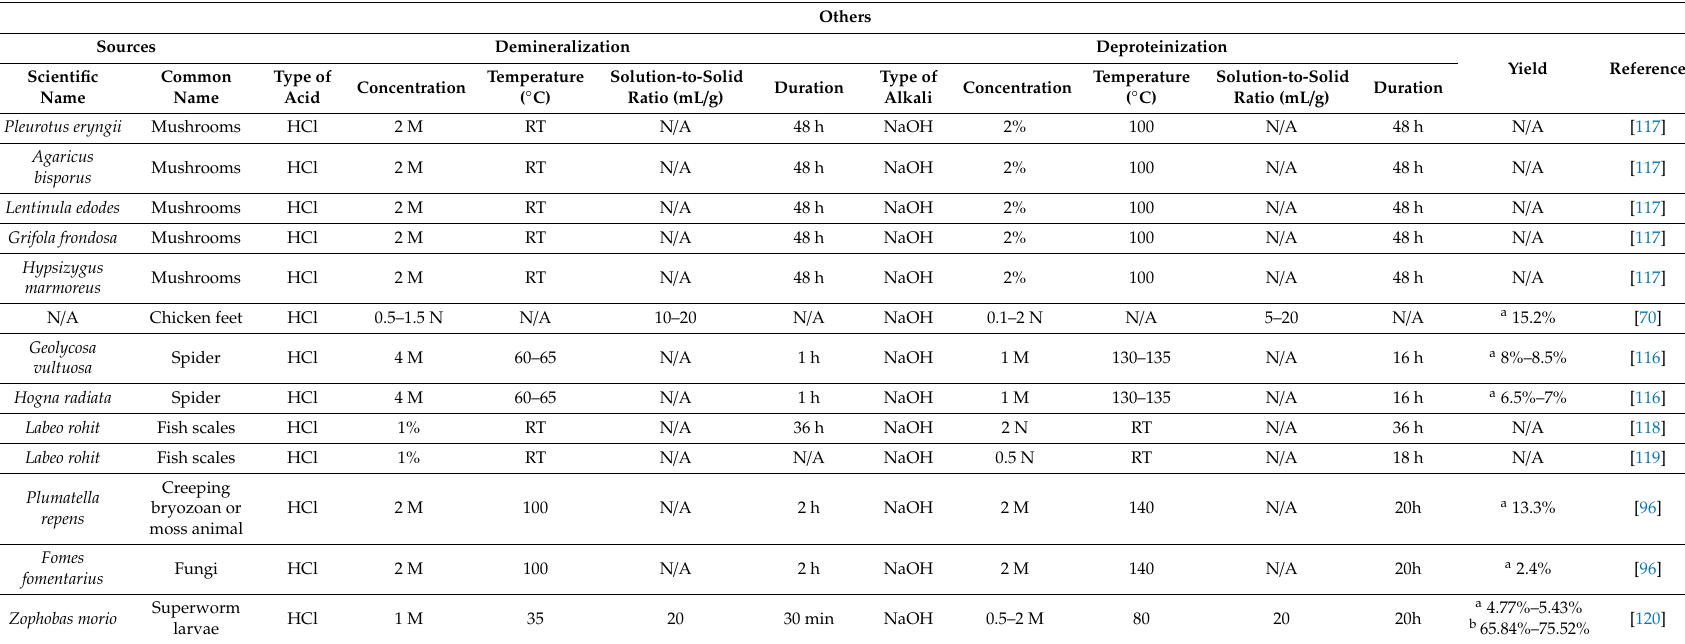
Table 3. A summary of the demineralization and deproteinization of chitin and chitosan from other